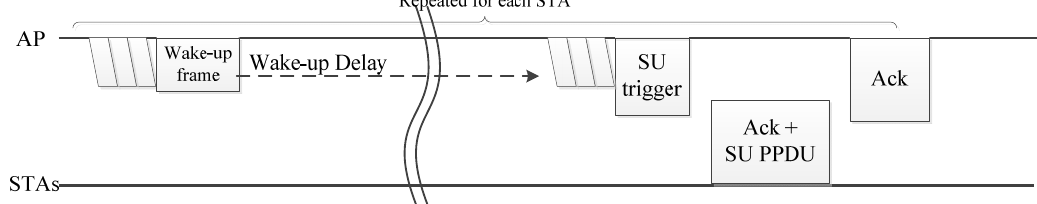
Figure 8. Data transmission procedure to gather the sensed data from sensors operated in MAC layer based on unicast transmission.